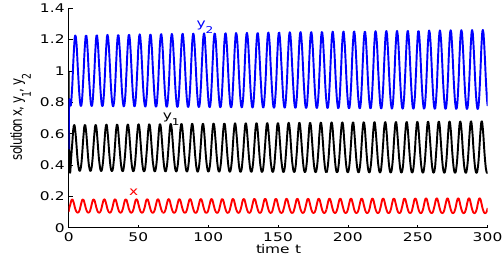
Figure 8: τ = 0.96 > 0.9429 = τ 0 , µ = 36 , E * = (0.1302, 0.4868, 0.9735) of system (1.4) is locally asymptotically stable, system (1.4) undergoes a Hopf bifurcation at E * when τ